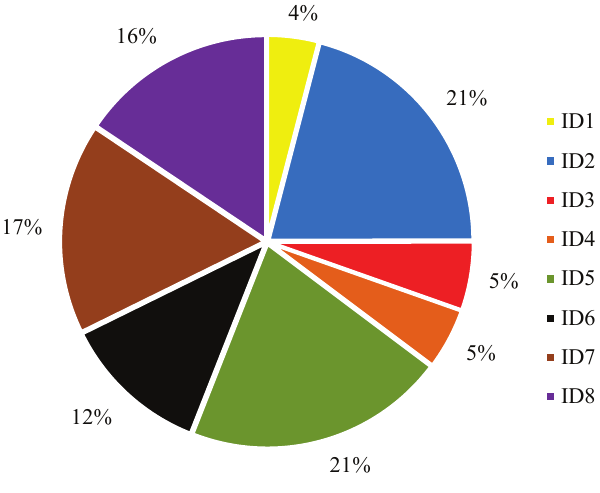
Figure 5. Participation percentage of categories: second